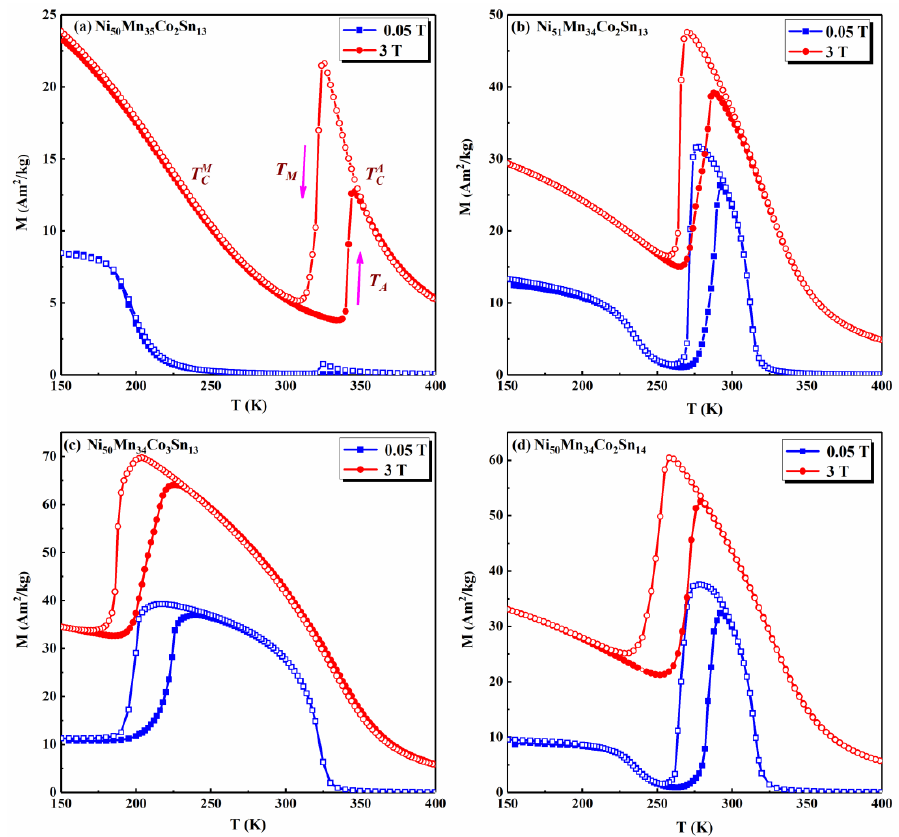
Figure 3. Temperature dependence of zero-field-cooling (ZFC) and field-cooling (FC) magnetization for Ni-Mn-Co-Sn alloys at 0.05 T and 3 T, respectively.